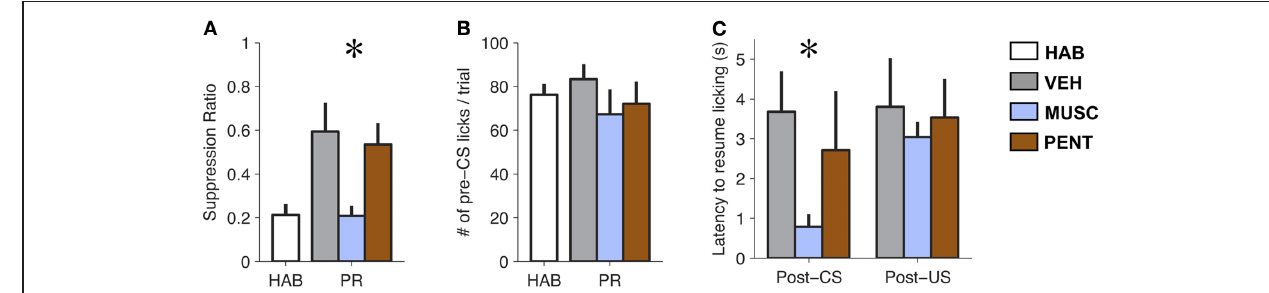
FIGURE 2 | Muscimol reduces expression of conditioned fear to pre-conditioning levels. (A) Mean ± SE CS-evoked suppression ratio from habituation (HAB), vehicle (VEH), muscimol (MUSC), and pentagastrin (PENT) sessions. Muscimol significantly reduced levels of suppression compared to vehicle and pentagastrin [Repeated Measures ANOVA, F ( 3 , 18 ) = 7 . 03, p < 0 . 005]. (B) Mean ± SE number of licks during the 20s pre-CS interval from HAB, VEH, MUSC and PENT sessions. ( n = 7). Drug-treatment did not affect pre-CS lick levels [Repeated Measures ANOVA, F ( 3 , 18 ) = 1 . 58, p > 0 . 2]. (C) Mean ± SE latency to lick (seconds) after a CS-alone